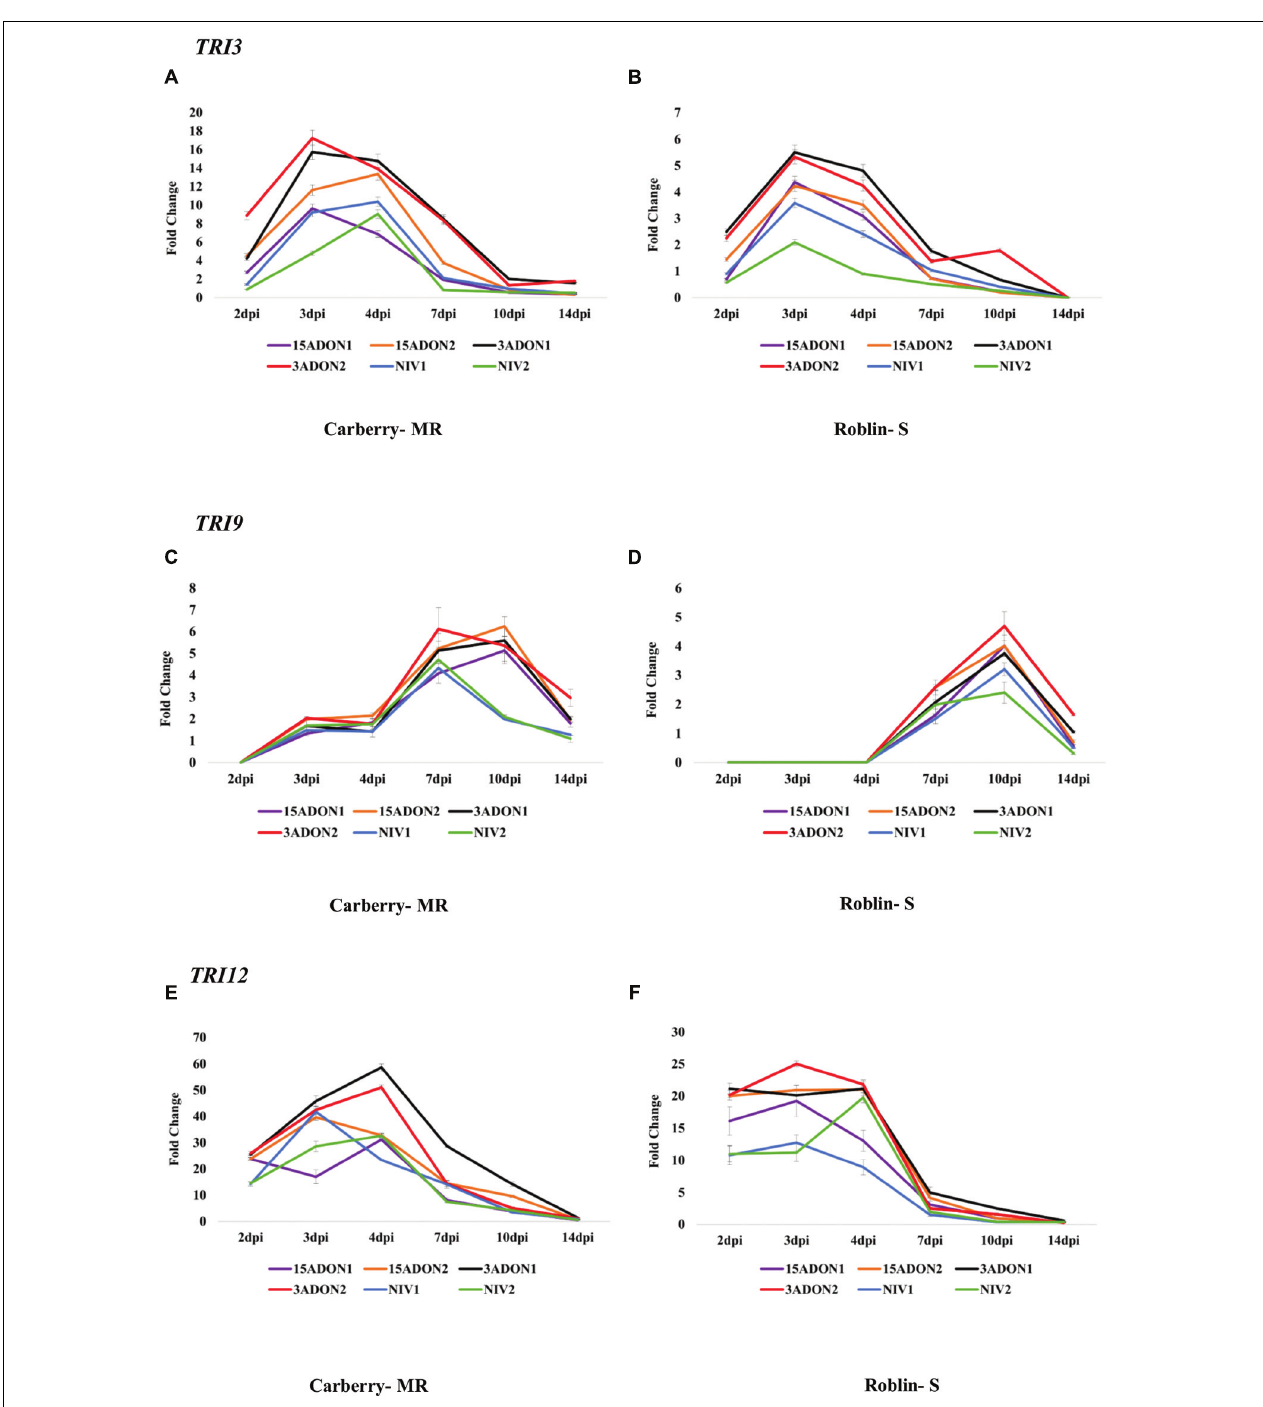
FIGURE 3 | Fold change in transcript levels of trichothecene 15- O -acetyltransferase ( TRI3 ) gene in cultivar Carberry (A) and cultivar Roblin (B), TRI9 gene in cultivar Carberry (C) and cultivar Roblin (D) and TRI12 gene in cultivar Carberry (E) and cultivar Roblin